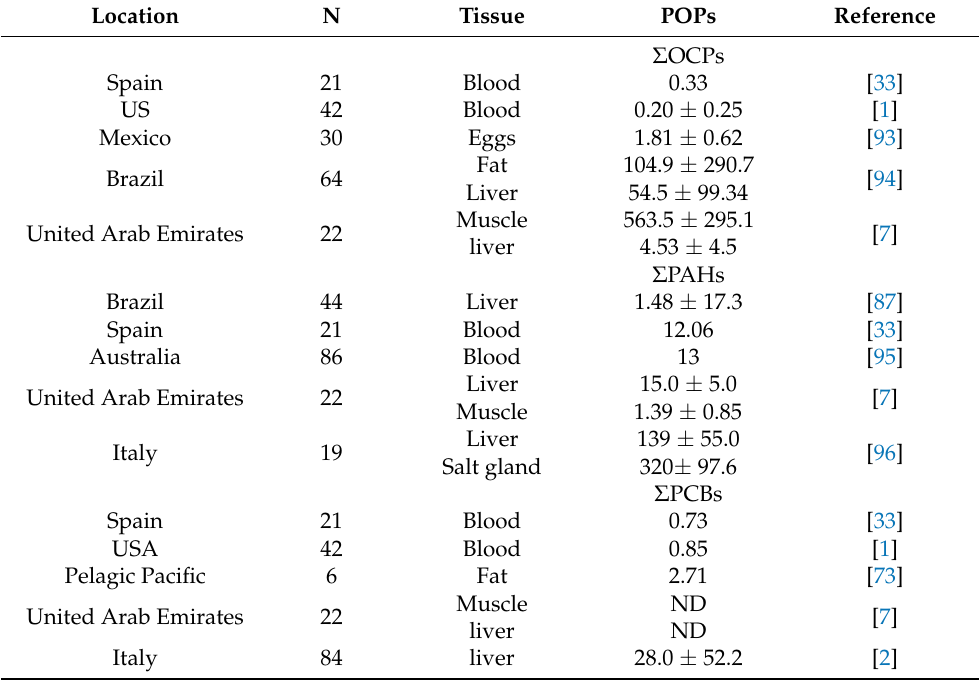
Table 2. POPs levels in sea turtles worldwide. Concentration for blood was expressed as ng/mL, whereas in all other cases they were expressed in